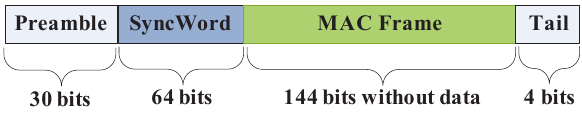
Figure 9. Schematic view of the physical layer protocol data unit (PPDU).